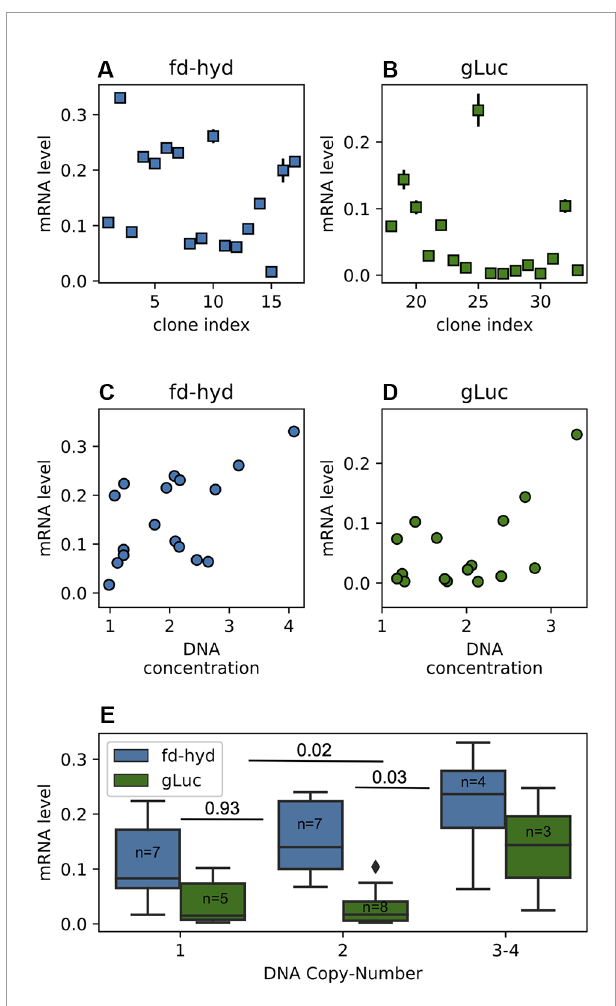
FIGURE 3 | Transgenes mRNA abundance in the fd-hyd and the gLuc clones. (A , B) Transgenes relative mRNA abundance in the fd-hyd and the gLuc clones, respectively. The mRNA levels are calculated as the ratio of the target's concentration to the reference gene ( CBLP ) concentration. The error bars represent the maximum and minimum values of Poisson distribution for the 95% con fi dence interval, as given by the QuantaSoft ™ software. (C , D) The effect of the relative raw DNA concentration (non-integer values) on transcription levels in the fd-hyd and the gLuc clones, respectively. Pearson correlation coeffcients are 0.56, p = 0.02 and 0.55, p = 0.027 for the fd-hyd and the gLuc clones, respectively. (E) The effect of the DNA copy- number on transcription levels. P-values were calculated using two-way ANOVA post-hoc test, and are shown between each copy-number group. The line within each box represents the median. The number of samples for each group is indicated within each box. The copy-number group “ 3-4 ” also contains one clone that harbors a copy-number of four (fd-hyd clone